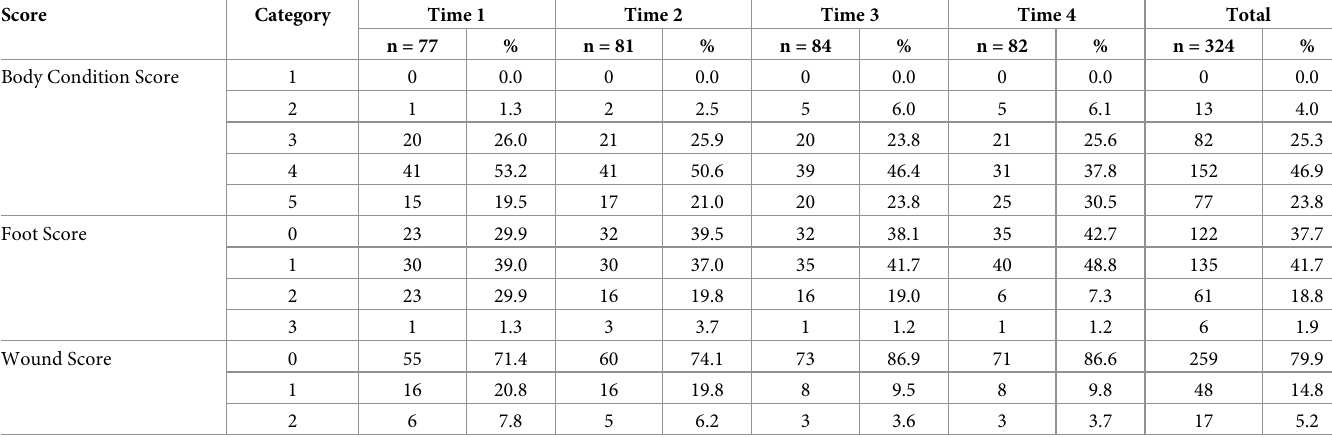
Table 3. Percentage of elephant body condition, foot health, and wound score categories from quarterly scoring periods over a 1-year period. Score